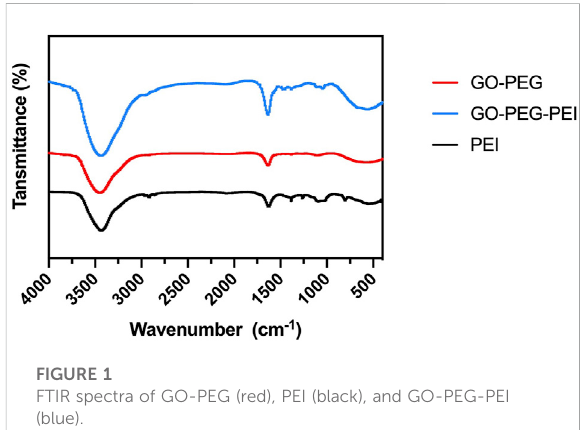
FIGURE 1 FTIR spectra of GO-PEG (red), PEI (black), and GO-PEG-PEI (blue).